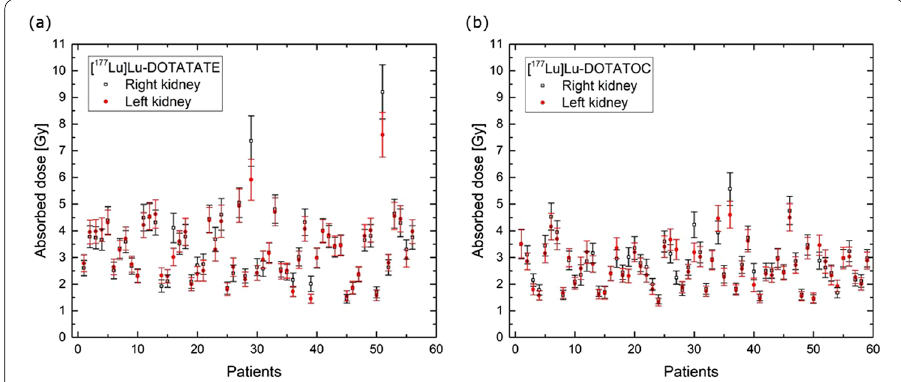
Fig. 7 Absorbed doses of both left and right kidneys with uncertainties indicated by error bars for a [ 177 Lu] Lu-DOTATATE and b [ 177 Lu]Lu-DOTATOC 3-SPECT fractions